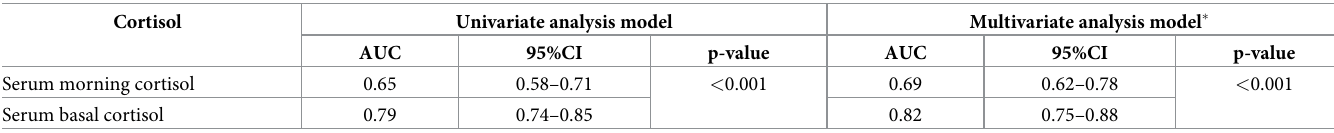
Table 2. Univariate and multivariate analyses for 0800h serum morning and basal cortisol levels.